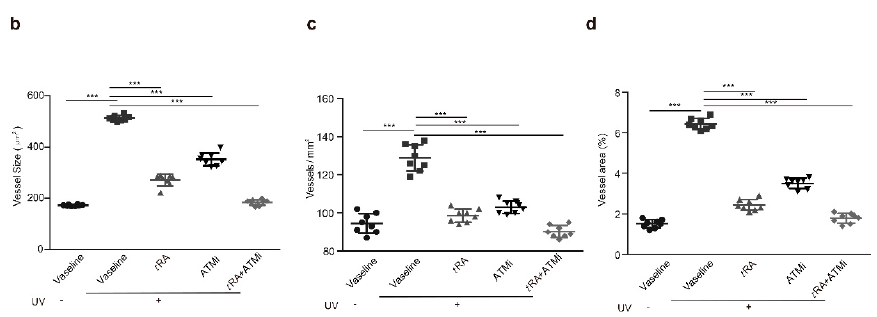
Figure 4. ATM inhibitor improved the effect of t RA against pathological skin angiogenesis caused by UV irradiation in mice. ( a ) Representative H&E (upper panel) and platelet/endothelial cell adhesion molecule-1 (CD31)-immunostained (lower panel) skin sections of C57BL/6 mice exposed to indicated treatments. ( b ) Vessel size, ( c ) vessel density, and ( d ) blood vessel area within 200 μ m from the